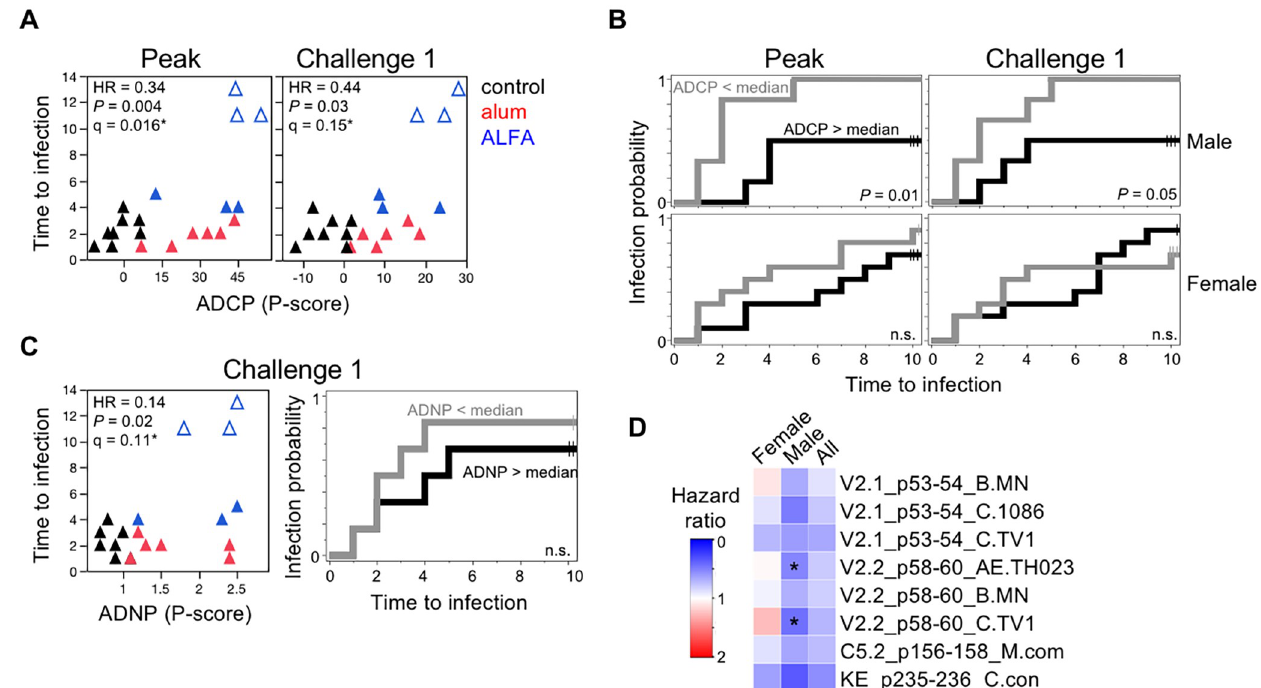
Fig 4. Vaccine-mediated immunologic correlates of protection. (A) ADCP phagocytic (P)-scores are plotted against the challenge number that resulted in SHIV infection for male animals. Peak (month 12.5) and time of challenge (month 15) responses are shown. Unadjusted ( P )- and FDR-adjusted (q)-values reflect significance test of the continuous effects of the responses on the risk of infection ( � , q < 0.2). Animals that resisted the ten prespecified challenges are depicted as open symbols. HR, hazard ratio. (B) Kaplan-Meier infection probabilities by ADCP responses above (gray) or below (black) the median at peak immunogenicity (left) and time of challenge (right) are shown for vaccinated animals by sex. Log-rank test p-values comparing high vs. low responders are indicated. (C) Time of challenge ADNP responses are plotted against the infecting challenge for male animals. FDR adjustment included all in-class assays (S3 Table), as the human neutrophil phagocytic assay was filtered out of the primary analysis due to correlation with the rhesus ADNP assay (S1 Table). Kaplan-Meier infection probability by ADNP responses above and below the median at the time of challenge are shown for male vaccinated animals. (D) Heatmap depicts association between peak rectal IgG Env epitope-specific responses and infection risk. Hazard ratios for the peptide array epitopes that remained in the analysis after filtering out highly correlated probes and exhibited protective trends in males ( P < 0.2) are shown, separately by sex and in all animals ( � , P < 0.05, q >